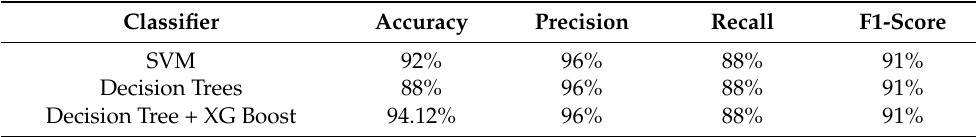
Table 3. Performance metrics for Machine Learning